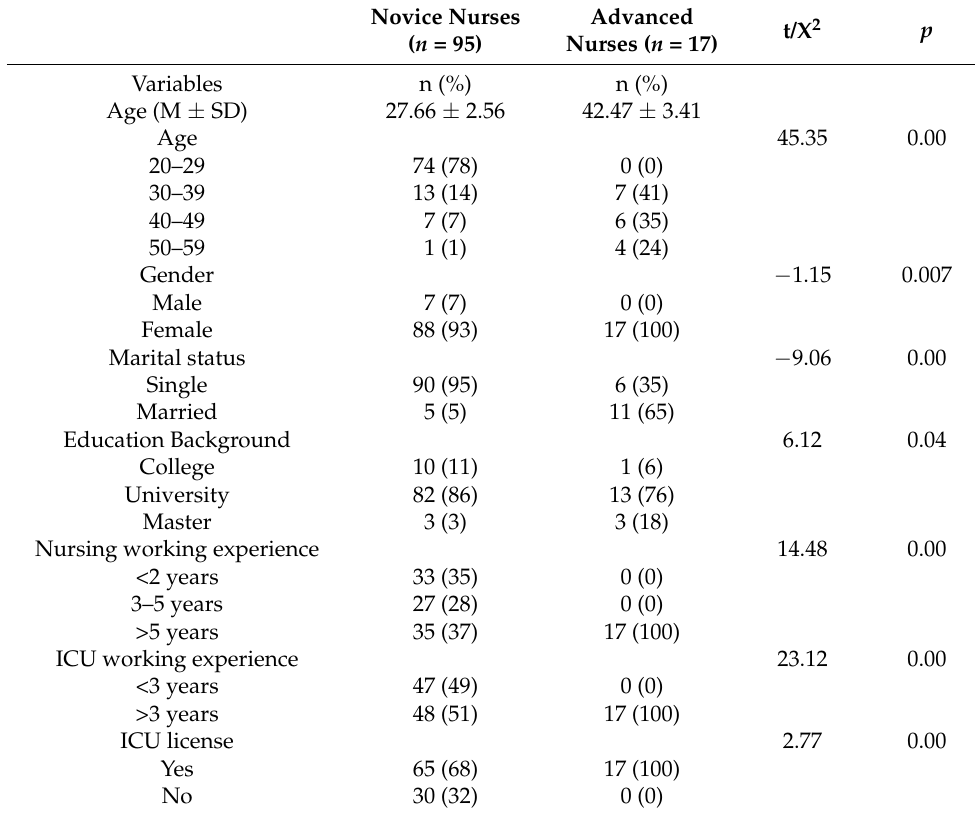
Table 2. Univariate analysis of the two groups’ demographic variables ( n =